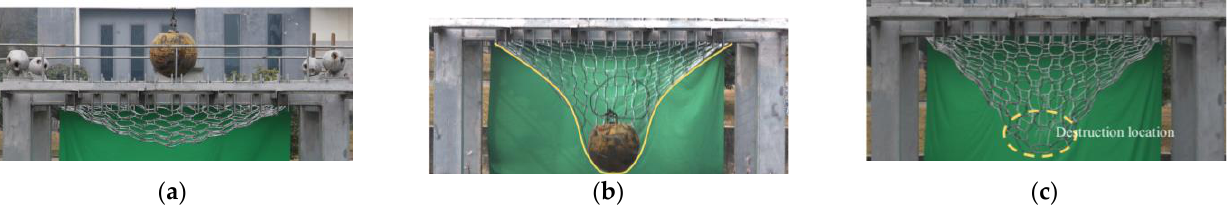
Figure 7. Test process: ( a ) test rock falls freely; ( b ) test rock impacts the ring net; ( c ) failure point.